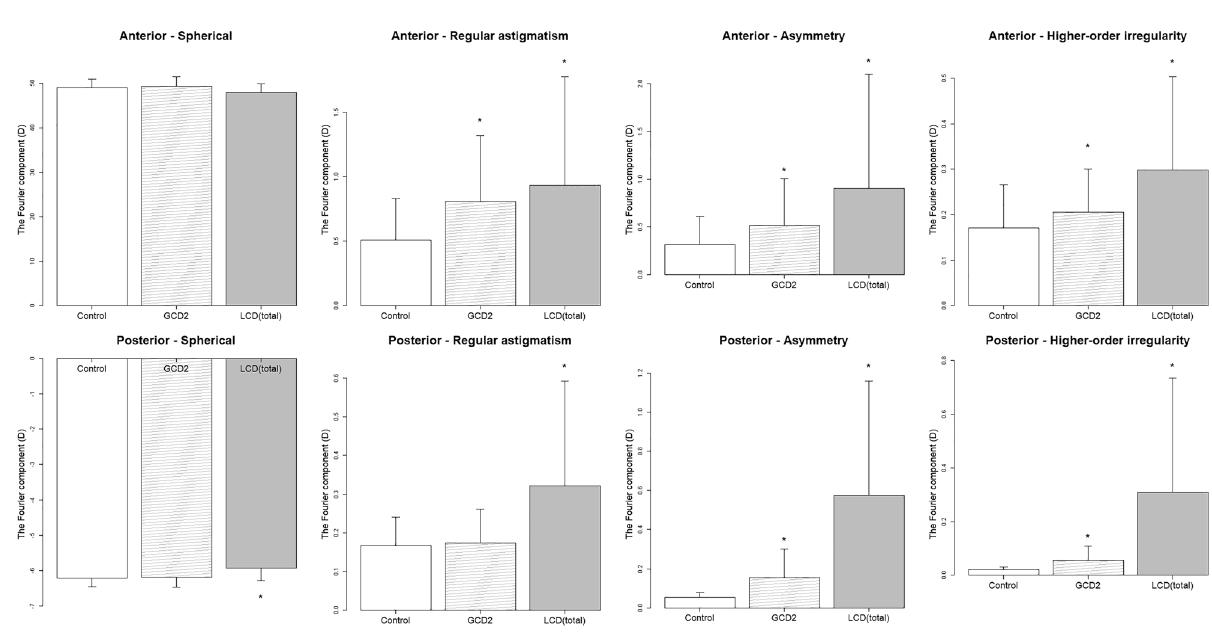
Figure 2. Fourier components for comparison between the phenotypes and controls. * indicates statistically significant difference. GCD = granular corneal dystrophy, LCD = lattice corneal in the anterior (regular astigmatism, asymmetry, and higher-order irregularity; P = 0.012, < 0.001, and < 0.001) and posterior (higher-order irregularity; P = 0.029) components (Table 3). In association between total corneal power and BCVA, positive associations were observed in regular astigmatism, asymmetry, and higher-order irregularity ( P < 0.001, P < 0.001, and P = 0.0011) (Table 3). In the analysis according to LCD subtypes, the eyes with LCD type 1 (LCD1) had higher anterior components (regular astigmatism, asymmetry, and higher-order irregularity; P = < 0.001, < 0.001 and < 0.001) (Fig. 3). Moreover, the anterior components (regular astigmatism and asymmetry; P = 0.046 and < 0.001) were positively associated with BCVA (Table 3). In association between total corneal power and BCVA, positive associations were similarly observed in regular astigmatism and asym- metry ( P = 0.02 and < 0.001) (Table 3).